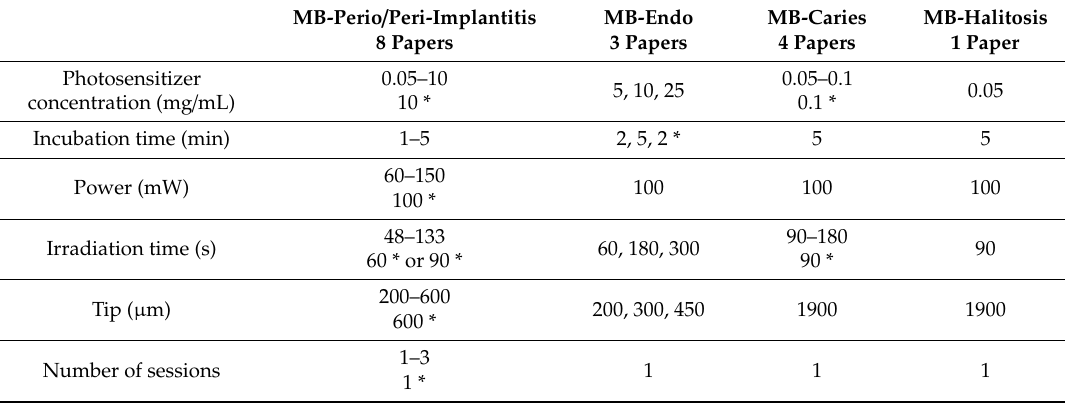
Table 9. Studies with methylene blue (MB). * Values predominantly applied. MB-Perio / Peri-Implantitis 8